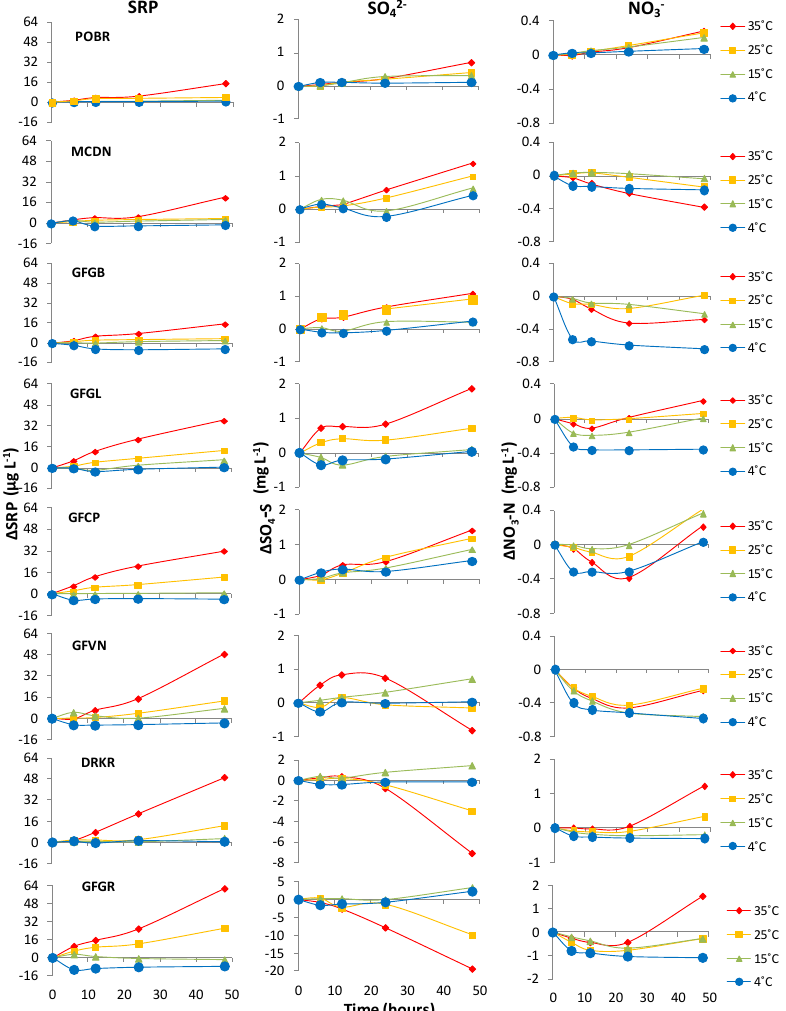
Fig. 5. Changes in nitrate, SRP and sulfate concentrations during the 48-h sediment incubations, relative to initial values before